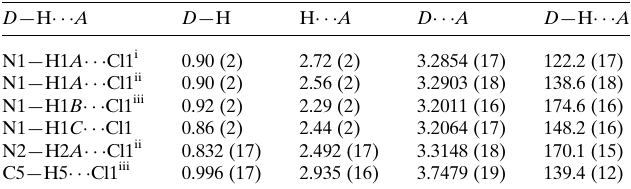
Table 1 Hydrogen-bond geometry (A˚ , (cid:4)